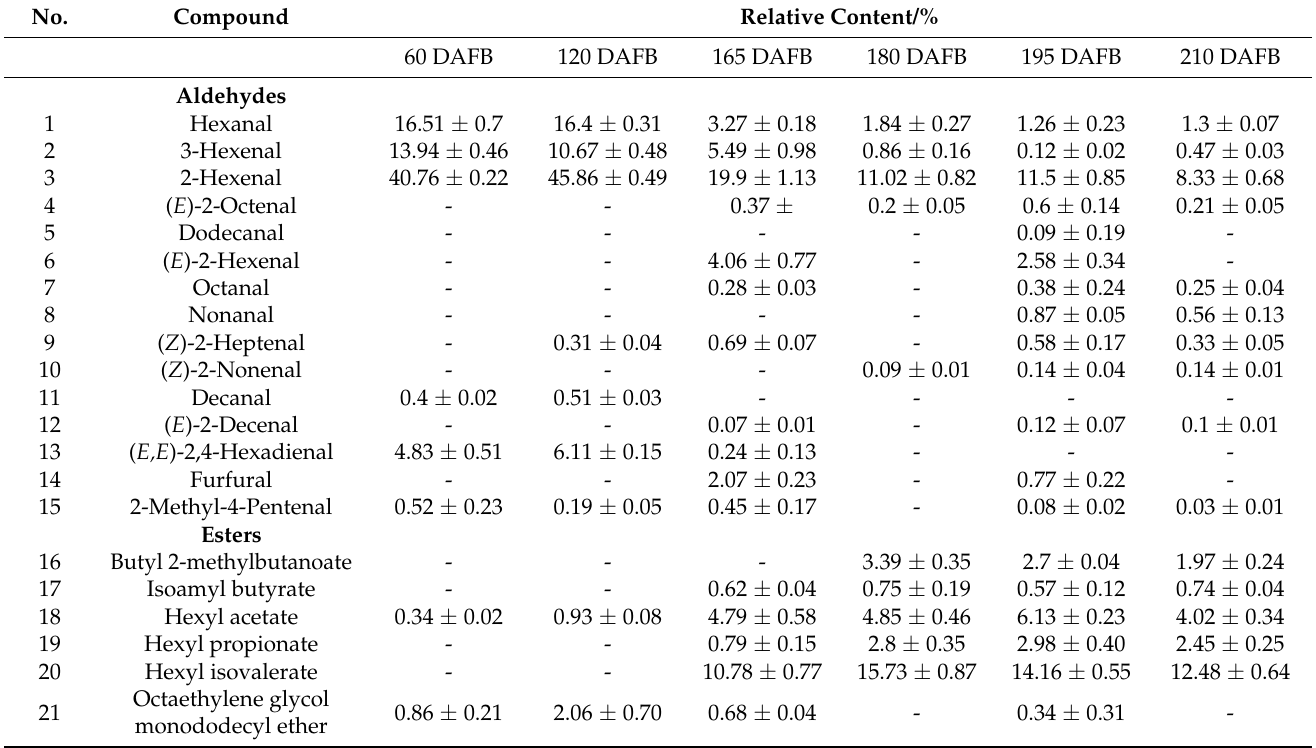
Table 2. Major volatile compounds detected in “Fuji” apple fruit during different developmental stages (DAFB, days after full